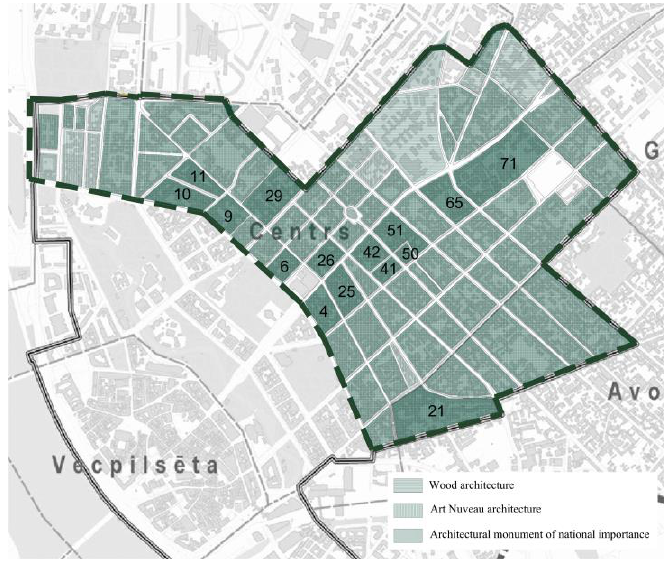
Fig. 4. Overlay map of architectural values in